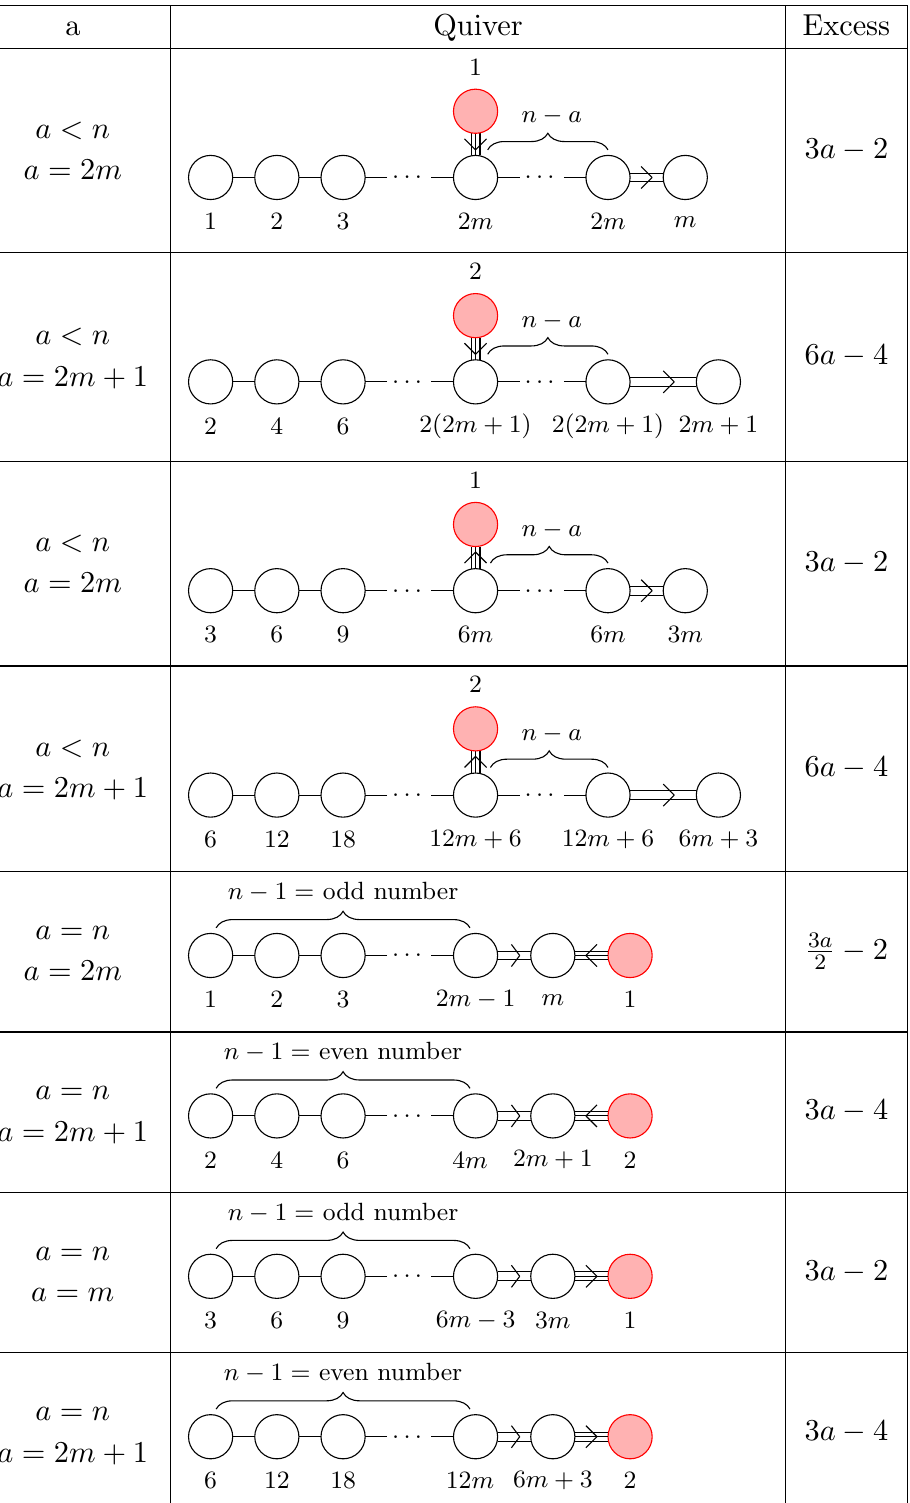
Table 29 . Exotic minimally unbalanced quivers with G = SO(2 n +1) and an extra triple laced edge.